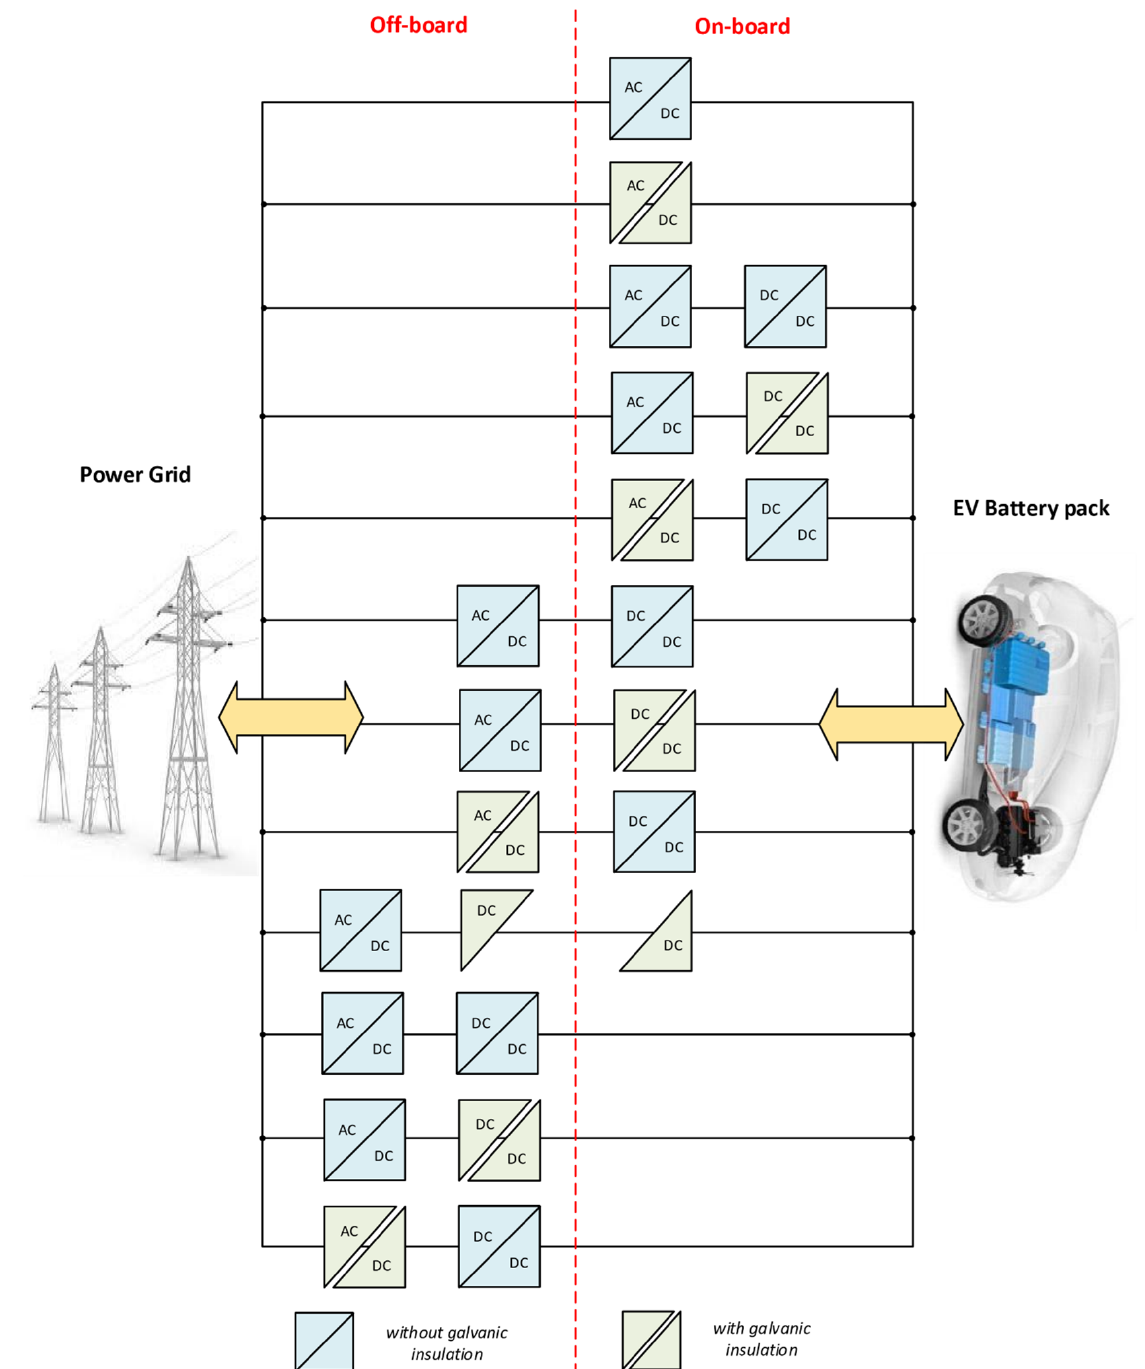
Figure 7. Possible structures for EV charger solutions.